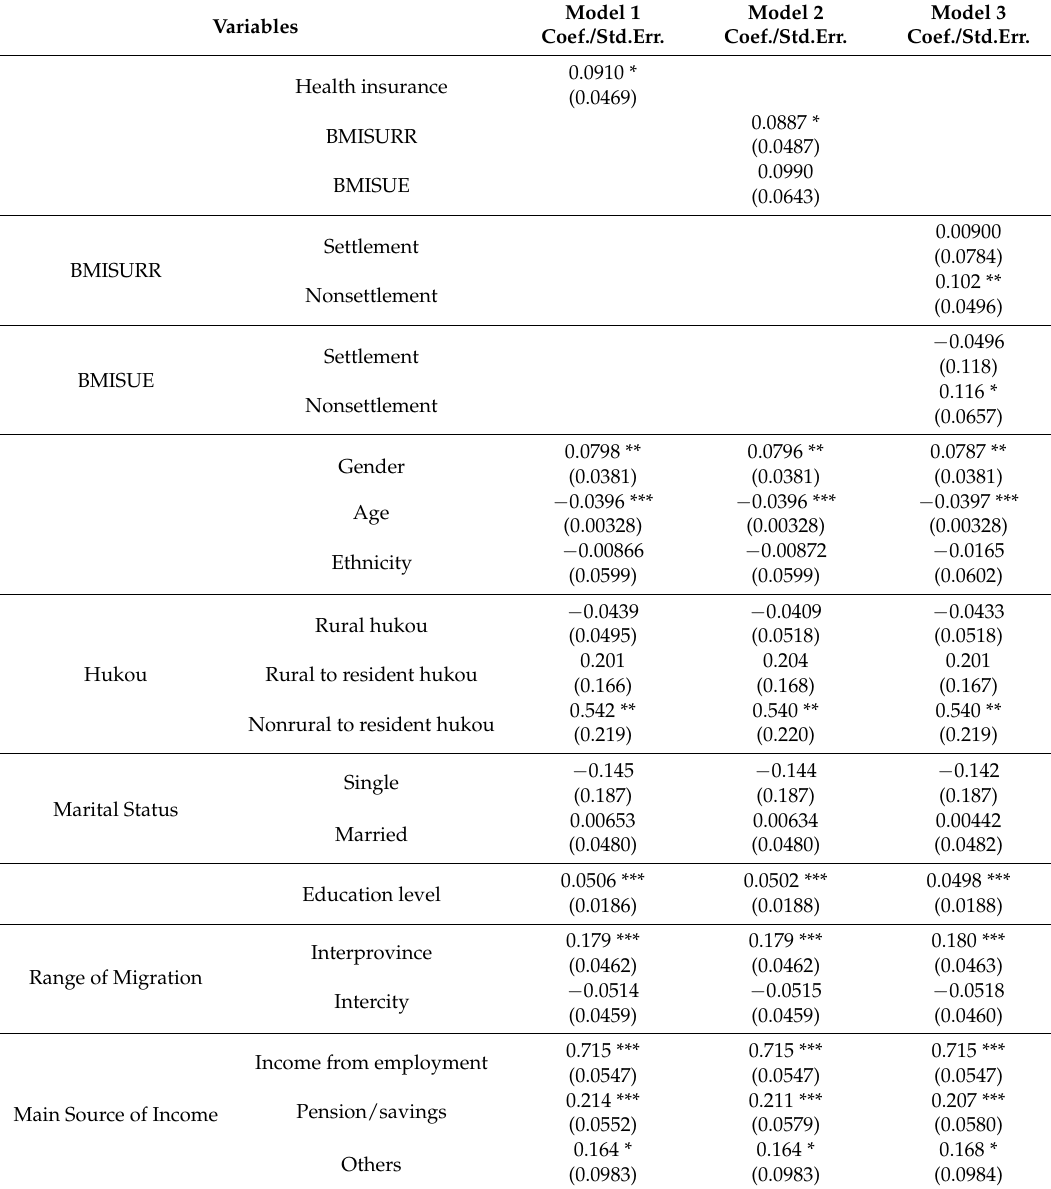
Table 4. Ordered probit regression results of the impact of health insurance on China’s senior floating